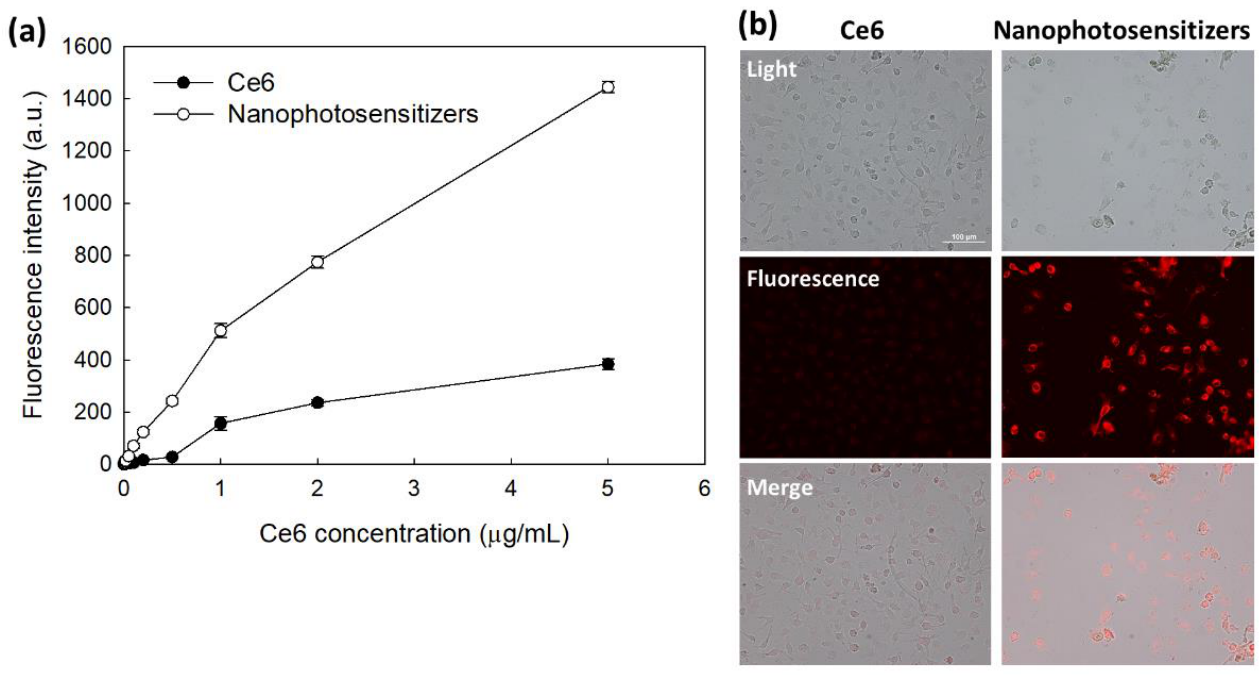
Figure 6. ( a ) Ce6 uptake ratio of HeLa cells. 2 × 10 4 HeLa cells seeded in 96 well plates were exposed to Ce6 or nanophotosensitizersas for 2 h. ( b ) Fluorescence microscope images of HeLa cells treated with Ce6 or mPEGseseCe6PBAP nanophotosensitizers (Bar = 100 µm). For fluorescence microscopic observation, 3 × 10 5 HeLa cells seeded in six well plates with cover glass were exposed Ce6 or nano- photosenstitizer for 60 min. Magnification: × 200.